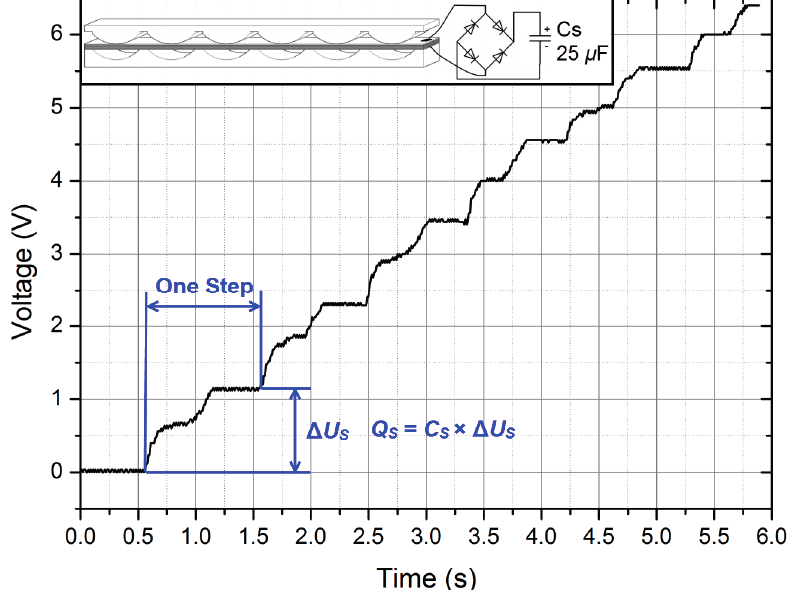
Figure 8. The voltage across the storage capacitor C